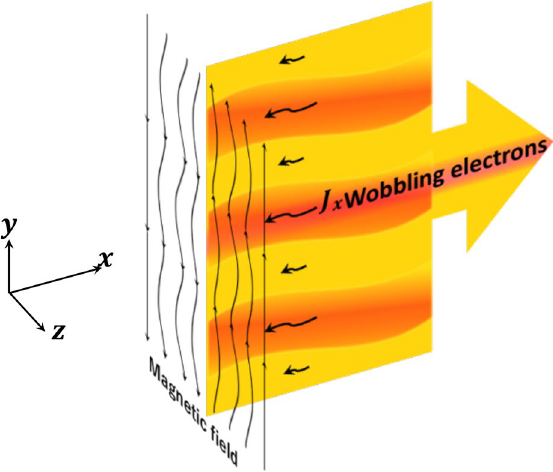
Figure 6. Schematic diagram for dynamic phase control in a plasma system sustained by an electron current sheet, in which electron filamentation and magnetic reconnection grow. The electron sheet current is oscillated along the sheet, and the perturbation phases introduced by the electron beam smooth and mitigate the perturbation amplitude.